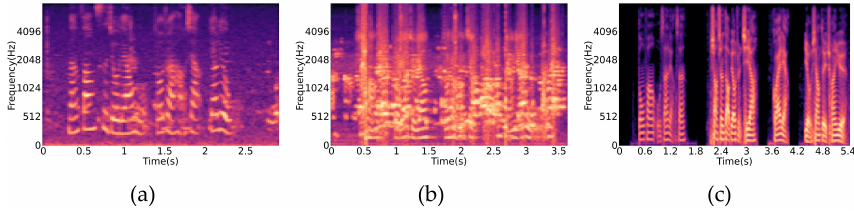
Figure 1. ( a – c ) Mel spectrogram of several ATC